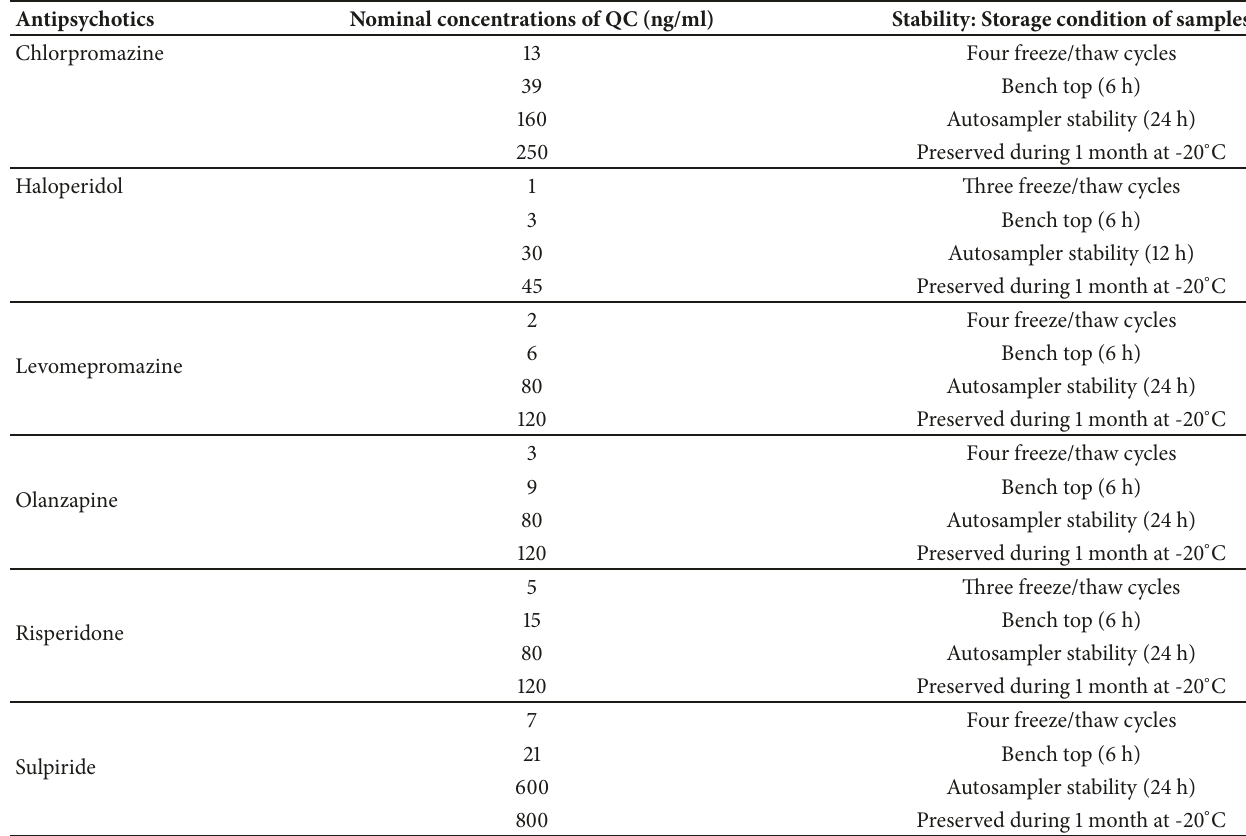
Table 7: Evaluation of sample storage procedure.